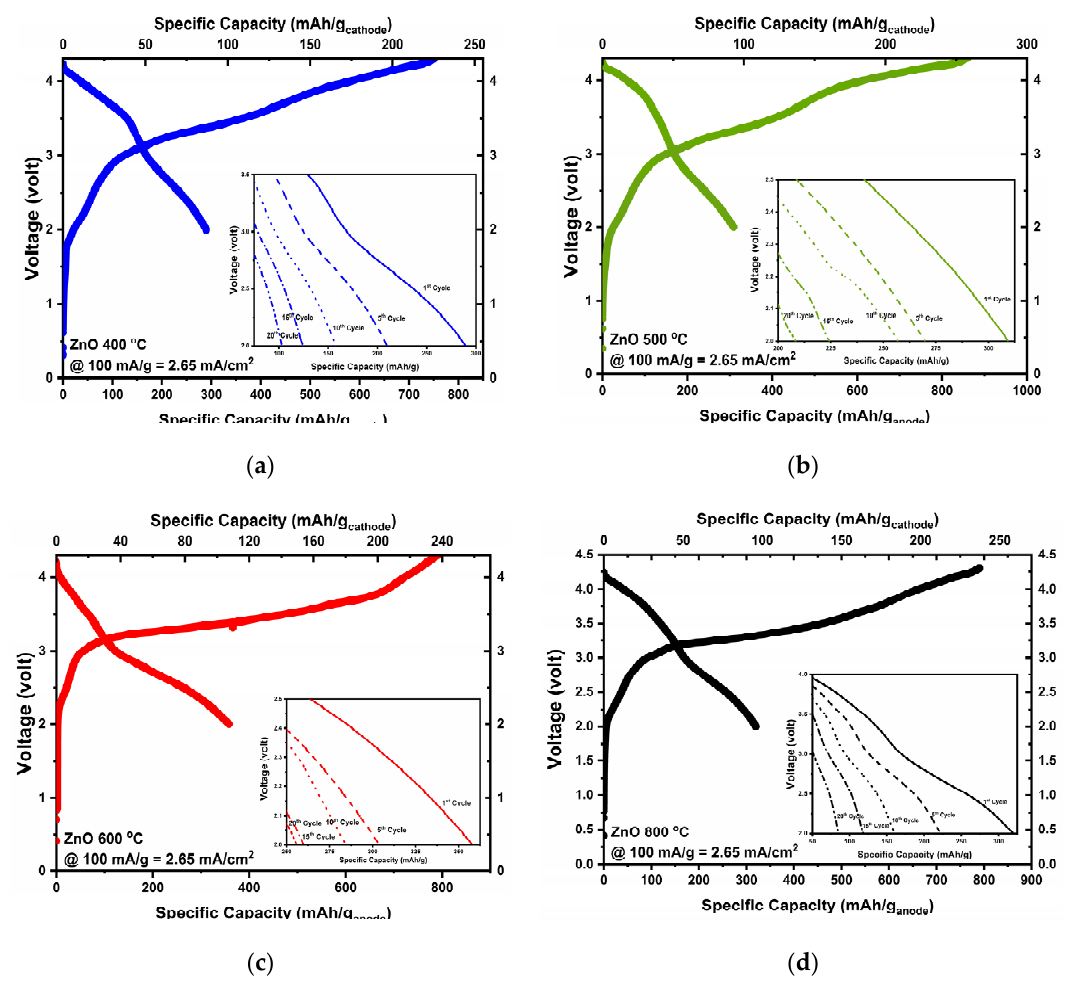
Figure 5. Charge–discharge curve of ( a ) NMC622/ZnO 400 °C, ( b ) NMC622/ZnO 500 °C, NMC622/ZnO 600 °C, and NMC622/ZnO 800 °C cells. Table 4. The charge–discharge capacity and energy density of NMC/Pure ZnO cells.